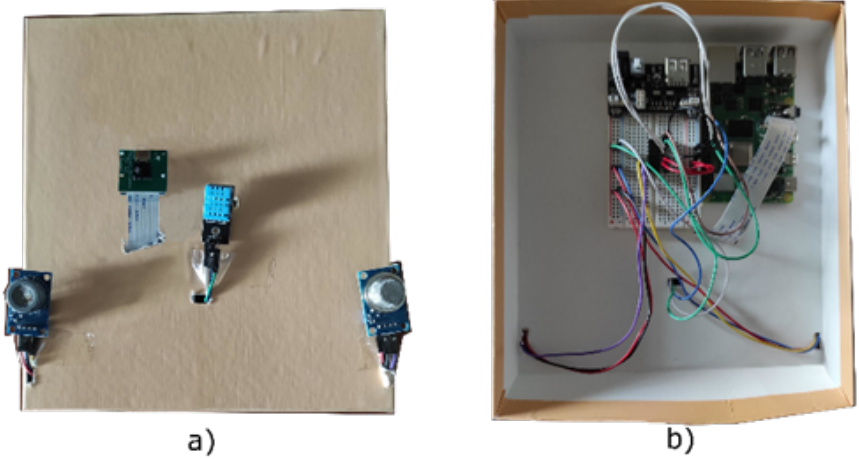
Figure 4. Developed prototype. The top of the realized prototype in which all the used sensors are exposed ( a ); the internal details of the realized prototype ( b